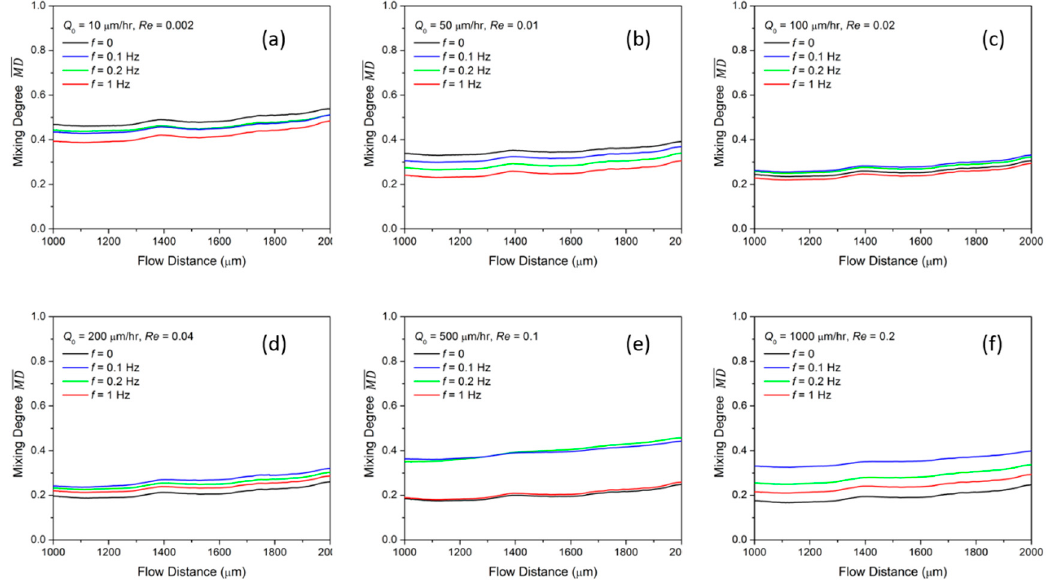
Figure 3. Averaged mixing degree MD of time pulsing Newtonian flow with di ff erent pulsing frequency at flow rates of ( a ) Q 0 = 10 µ L / h; ( b ) Q 0 = 50 µ L / h; ( c ) Q 0 = 100 µ L / h; ( d ) Q 0 = 200 µ L / h; ( e ) Q 0 = 500 µ L / h and ( f ) Q 0 = 1000 µ L / h.